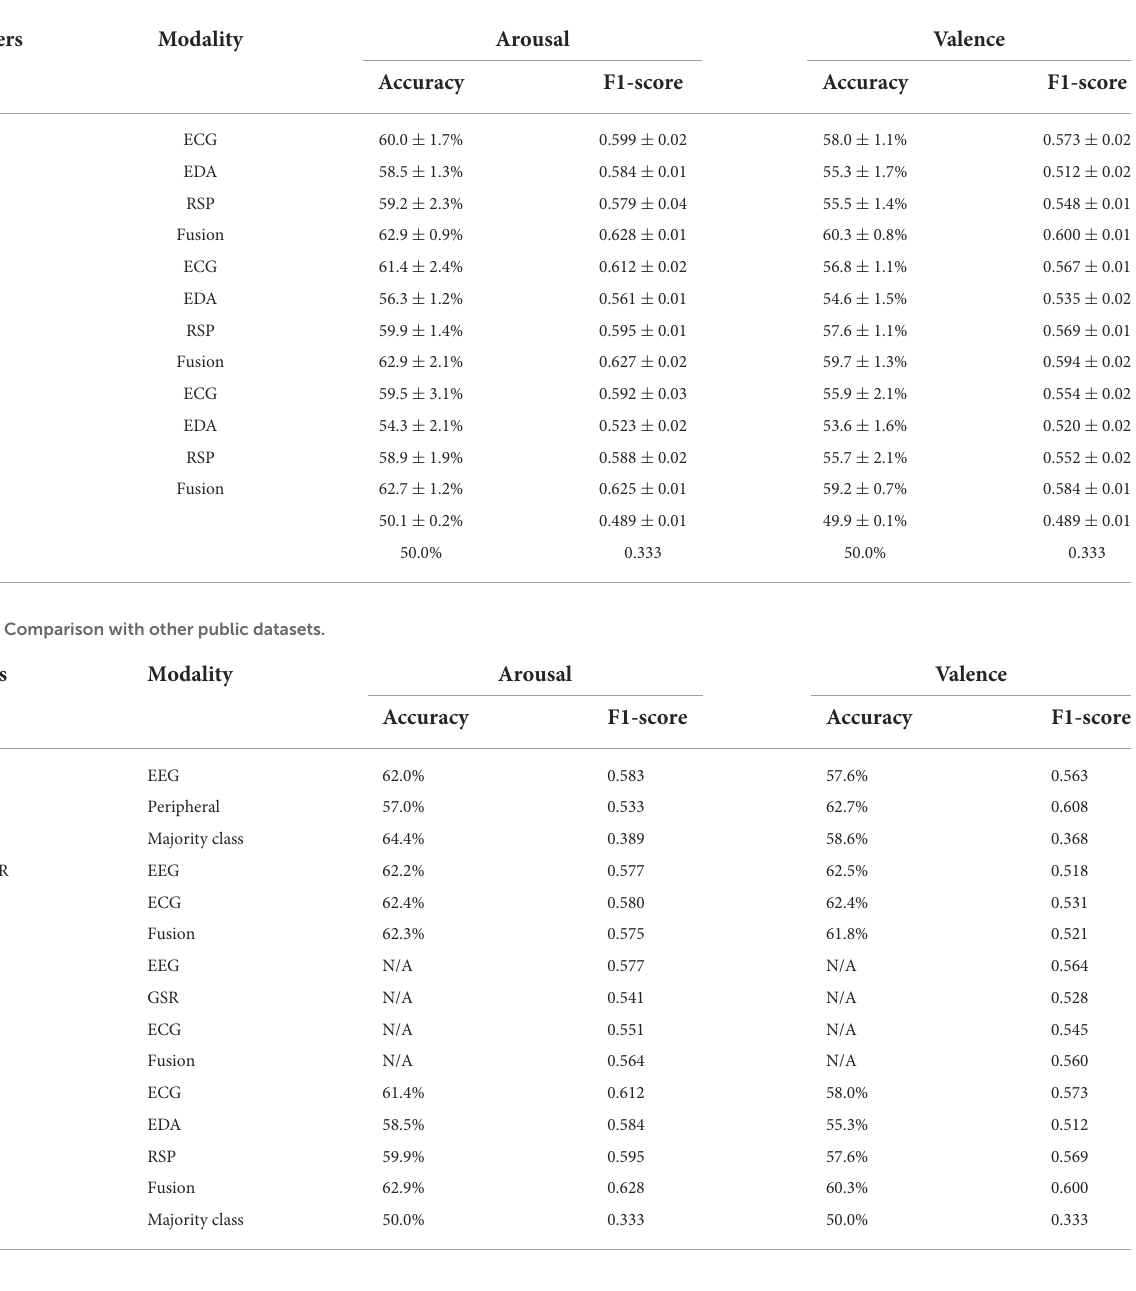
TABLE 5 Baseline of our dataset.